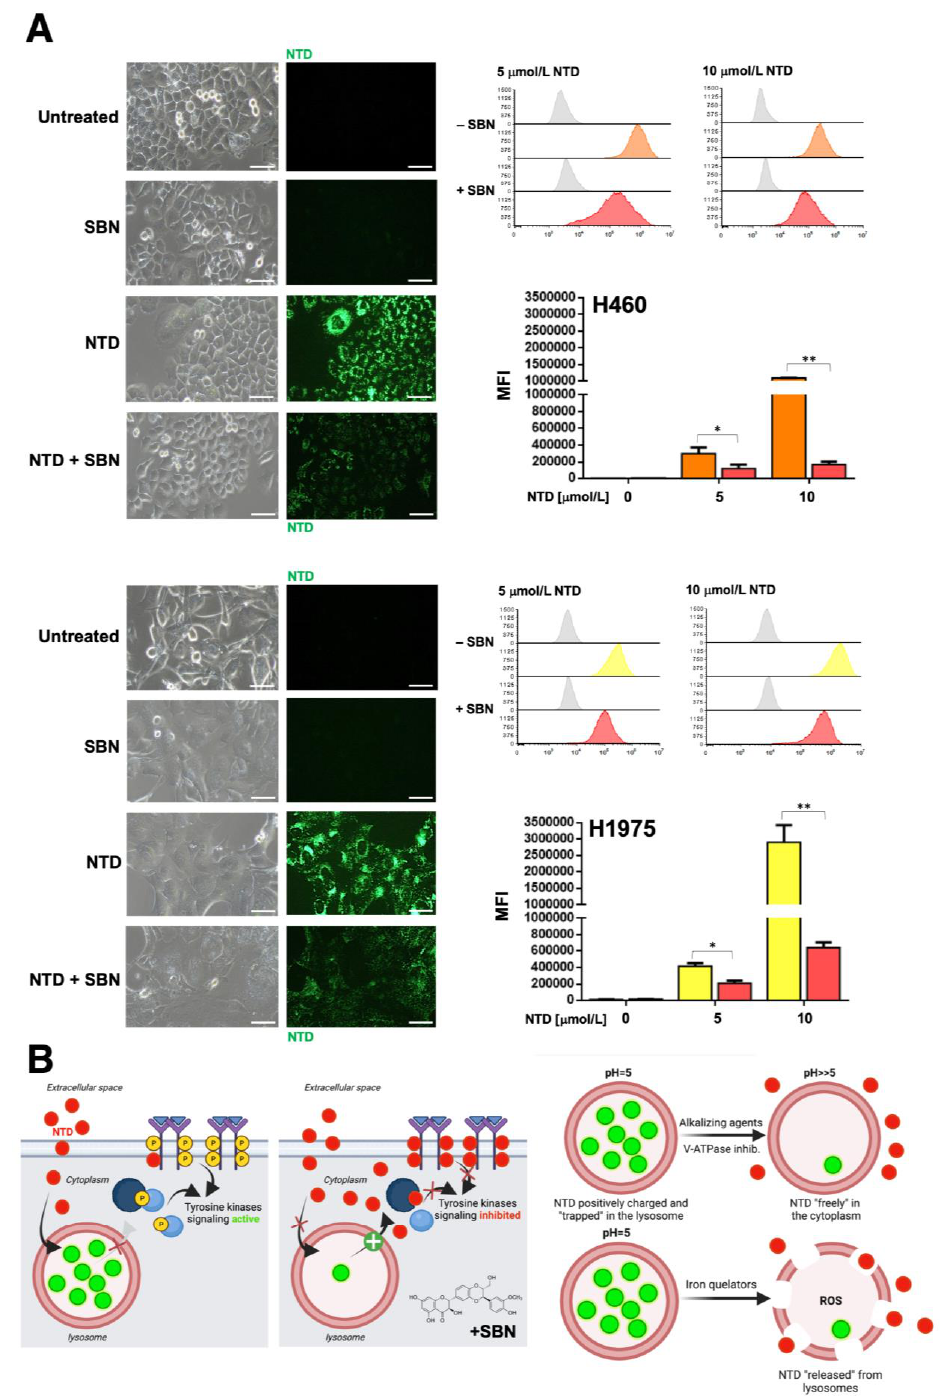
Figure 5. Effects of silibinin on the lysosomal sequestration of nintedanib in nintedanib-resistant NSCLC tumor cells. ( A ) The impact of 100 µ mol/L silibinin (SBN; 1 h pre-treatment) on the intracellular accumulation of 5 and 10 µ mol/L nintedanib (NTD) was analyzed by live cell fluorescence microscopy ( left panels ) and flow cytometry ( right panels ) after 3 h drug exposure. Each experimental value represents the mean NTD-associated fluorescence ( columns ) ± S.D. ( bars ) of 3 independent experiments. The scale bar indicates 50 µ m. Comparisons of means were performed by ANOVA. p values < 0.01 and < 0.001 were considered to be statistically significant (denoted as * and **, respectively; n.s. not significant). ( B ) Sequestration of NTD into lysosomes provides a mechanism of NTD resistance in NSCLC cells. Overcoming NTD trapping by alkalizing lysosomes (e.g., by using NH 4 Cl, chloroquine, bafilomycin A) or disrupting lysosomes containing sequestered NTD (e.g., by iron chelators) can potentiate the effects of NTD treatment. (MFI: Median Fluorescence